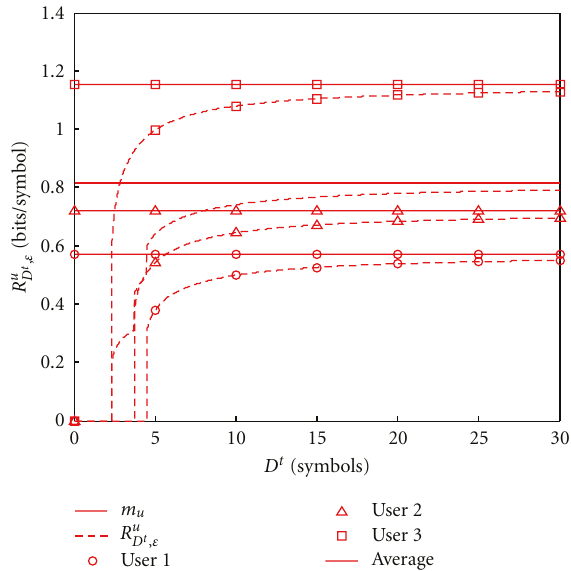
Figure 2: Achievable users’ rates with Round Robin scheduling in an uncorrelated channel. Three users with γ respectively. ε = 0 . 1. β u = 1.